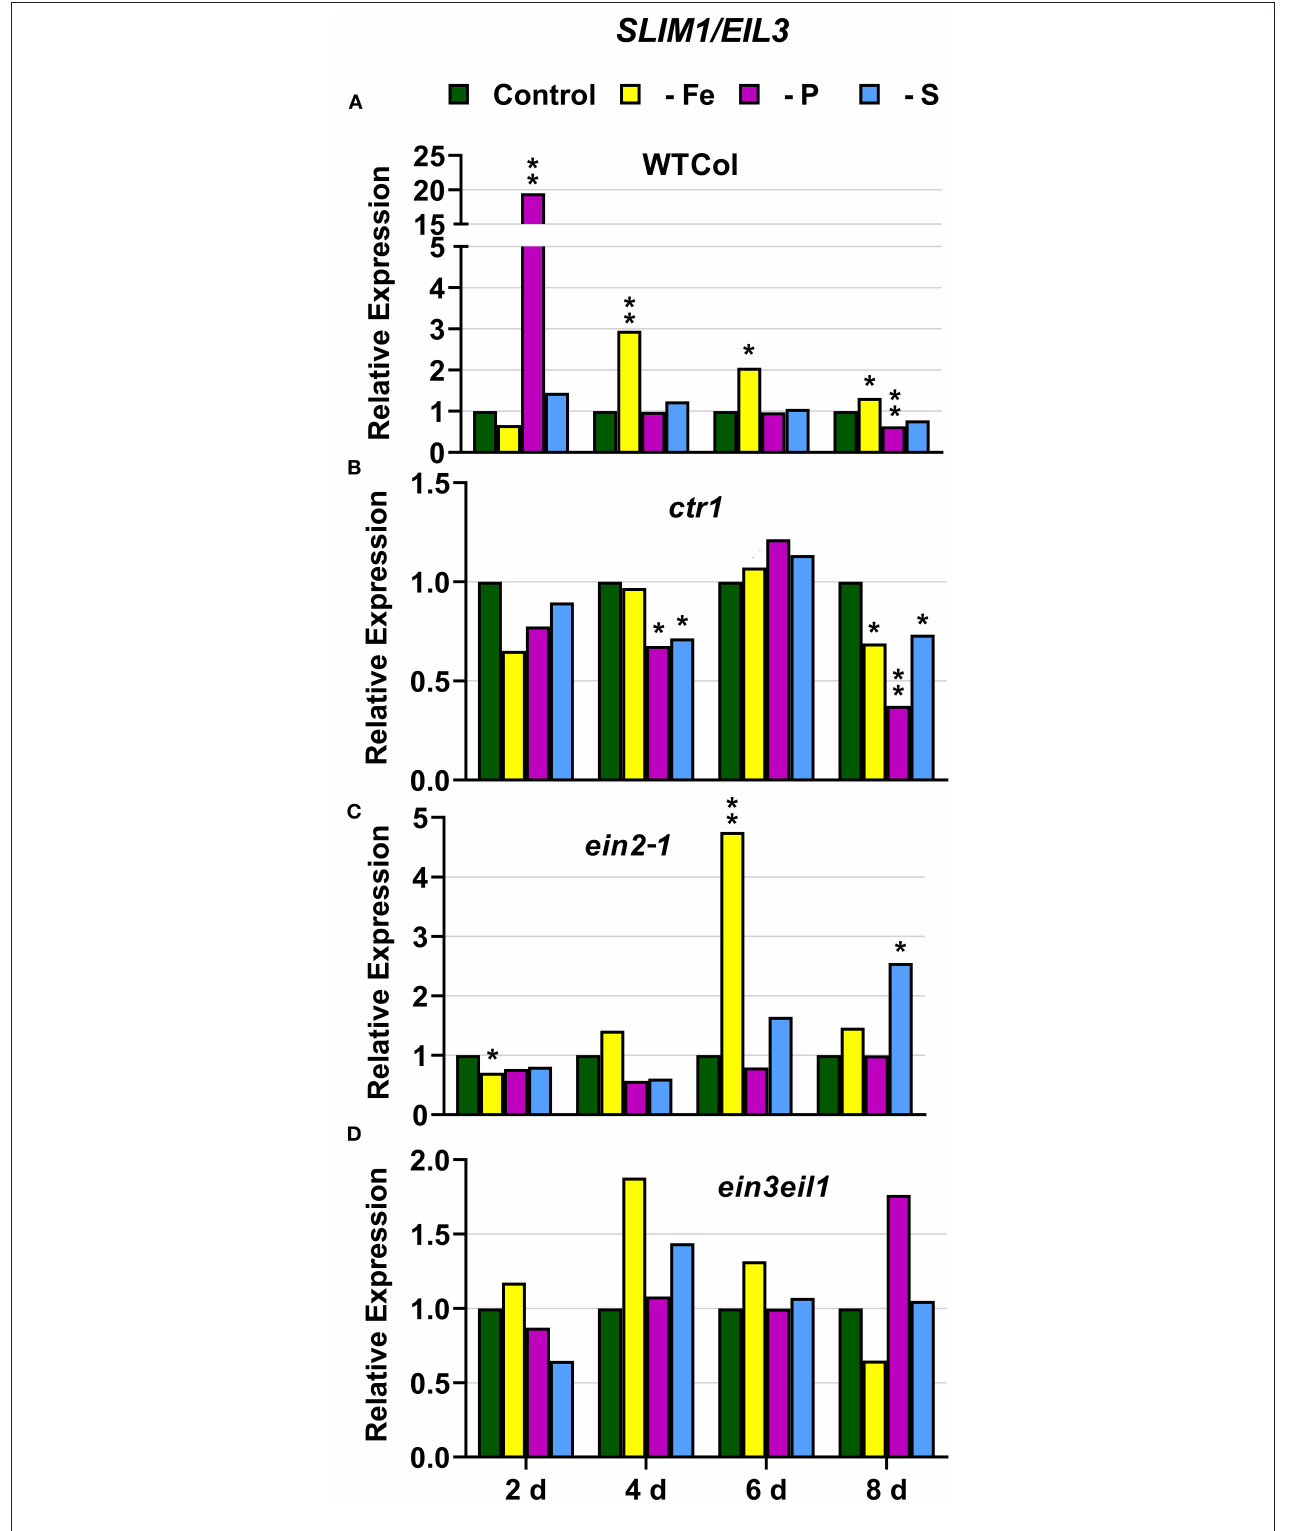
FIGURE 11 | Effect of Fe, P or S deficiency on the expression of the S-related gene SLIM1/EIL3 in roots of the Arabidopsis WT Columbia and its ethylene mutants ctr1 , ein2-1 and ein3eil1 (A–D) . Treatments and gene expression determination as in Figure 1 . Within each day and genotype, * or ** indicate significant differences ( P < 0.05 or P < 0.01) in relation to the control